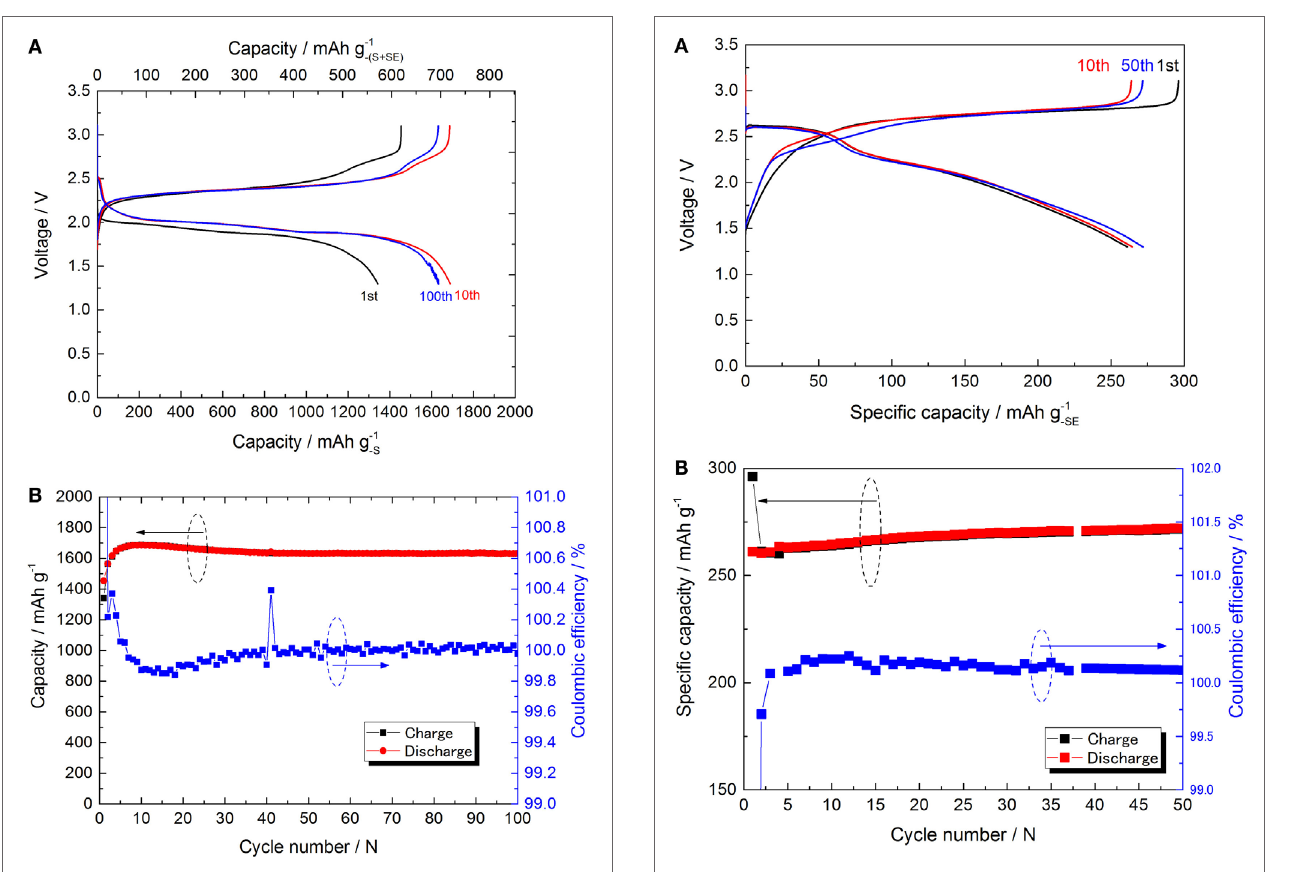
FigUre 6 | (a) Charge/discharge curves of S-cell for 1st, 10th, and 100th cycle at 25°C. All the charge/discharge was done at 0.15 C (0.25 mA cm − 2 ) constant current with the cutoff potential of 3.1 and 1.3 V. (B) Charge/ discharge capacities and the coulombic efficiency are plotted versus the cycle.